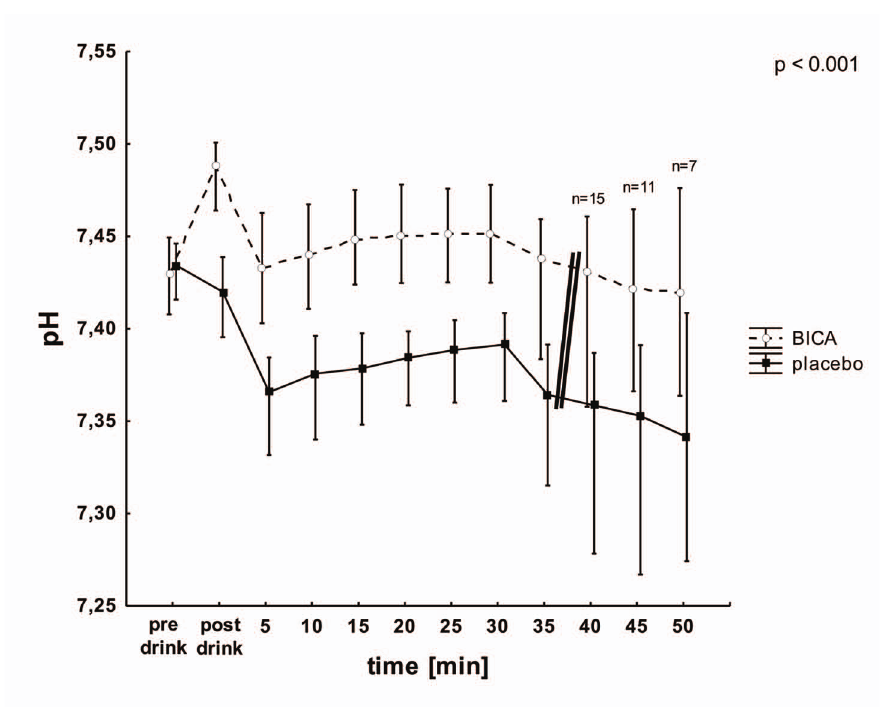
Fig. 3. pH-levels before (pre drink), after ingestion (post drink) and during constant load tests (mean ¡ SD) for the BICA (open circles) and placebo (closed squares) trials. Double bar 5 decrease in number of exercising subjects (n , 21). p 5 significant interaction between condition and